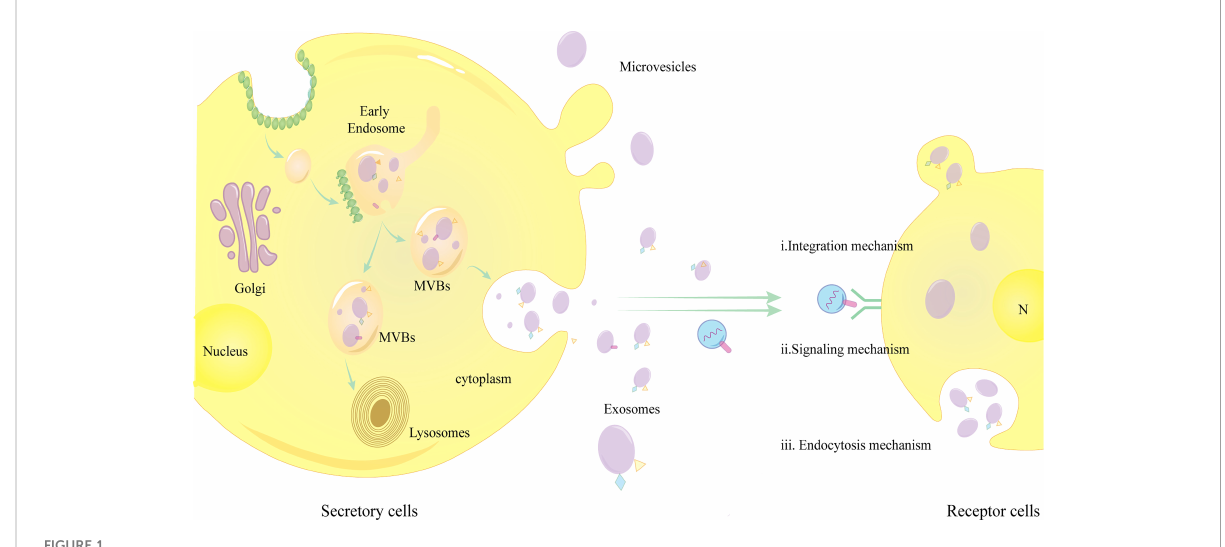
FIGURE 1 Exosome release and binding to target